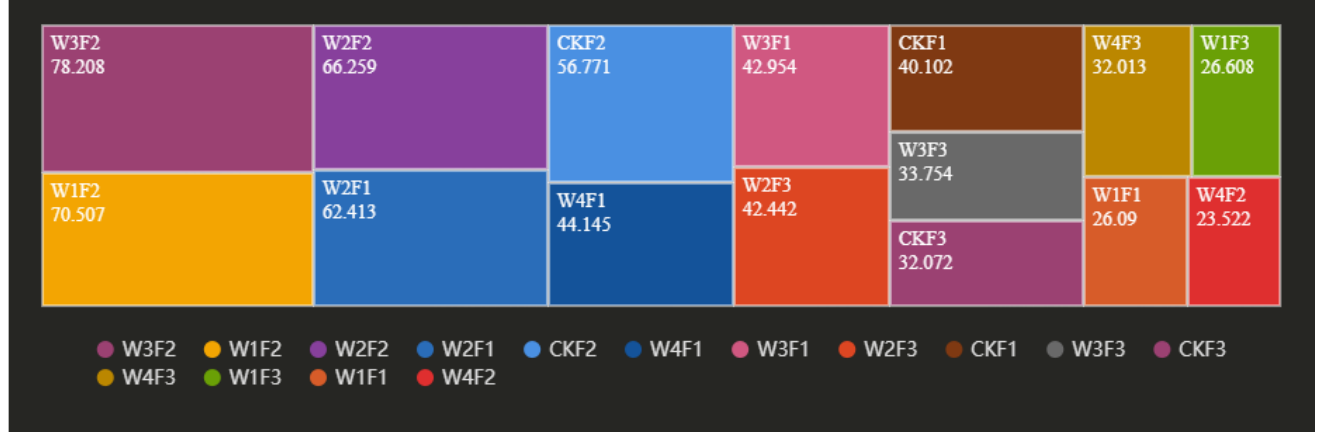
Figure 7. The comprehensive evaluation score and ranking using the fuzzy Borda method.